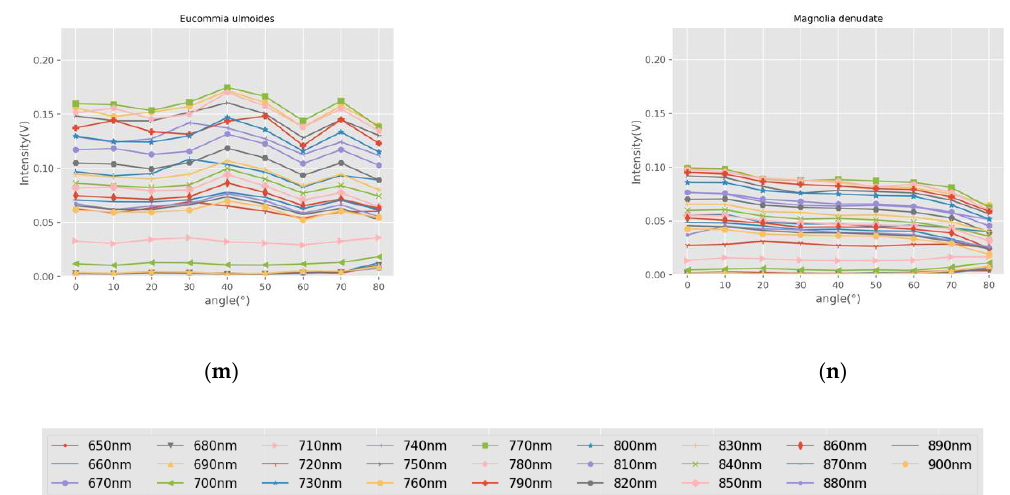
Figure 9. The corrected backscatter intensity of different samples. ( a ) 100% standard reference board; ( b ) 70% standard reference board; ( c ) 40% standard reference board; ( d ) Wood product; ( e ) Sidewalk brick; ( f ) Floor tile; ( g ) Marble; ( h ) Car shell sample; ( i ) Ficus elastic; ( j ) Codiaeum variegatum; ( k ) Fraxinus pennsylvanica; ( l ) Yellow leaf of Fraxinus pennsylvanica; ( m ) Eucommia ulmoides; ( n ) Magnolia denudate.